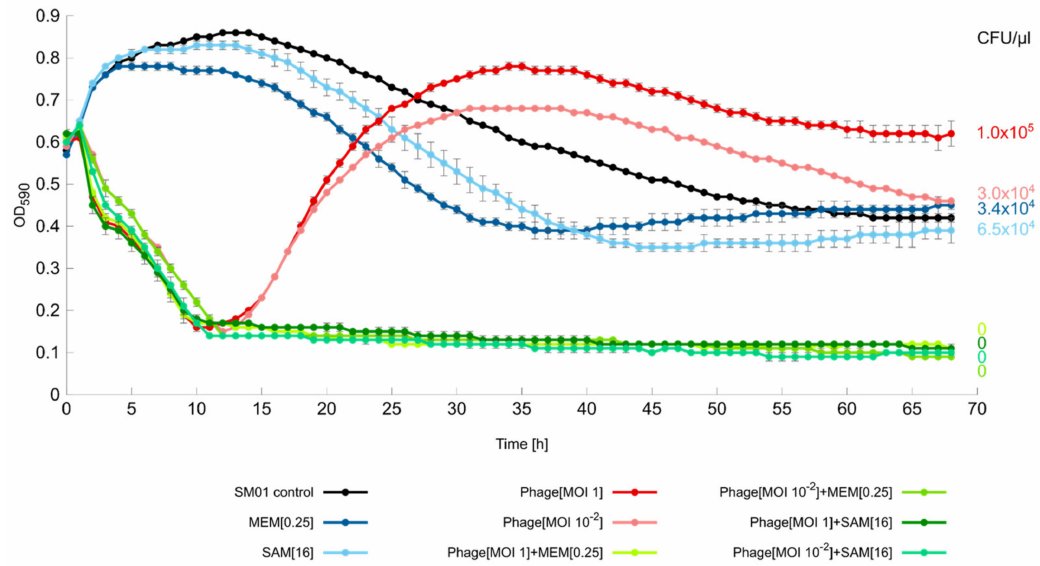
Figure 3. Liquid infection assays against S. marcescens strain SM01 with or without the antibiotic ampicillin / sulbactam (SAM, 16 mg / L) or meropenem (MEM, 0.25 mg / L). Reduction was measured via opticaldensityat590nm(OD 590 ). Eachexperimentwasperformedintriplicateandthemeans ± standard errorsareindicated. Thenumberofcolonyformingunits / µ L(CFU / µ